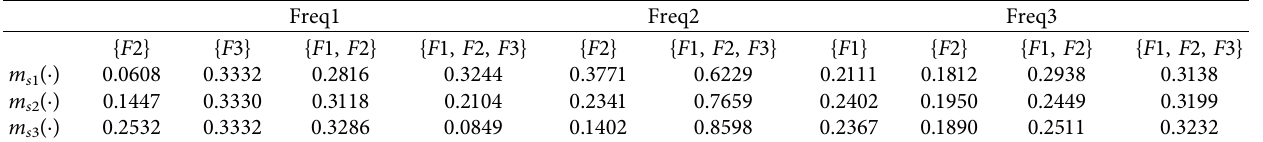
Table 5: The negation of BPAs.